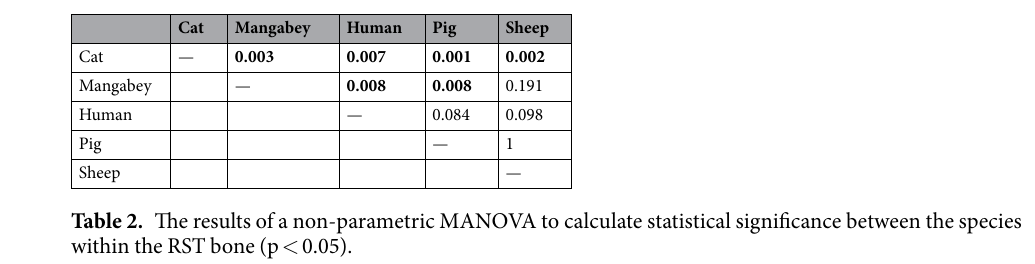
Table 2. The results of a non-parametric MANOVA to calculate statistical significance between the species within the RST bone (p <